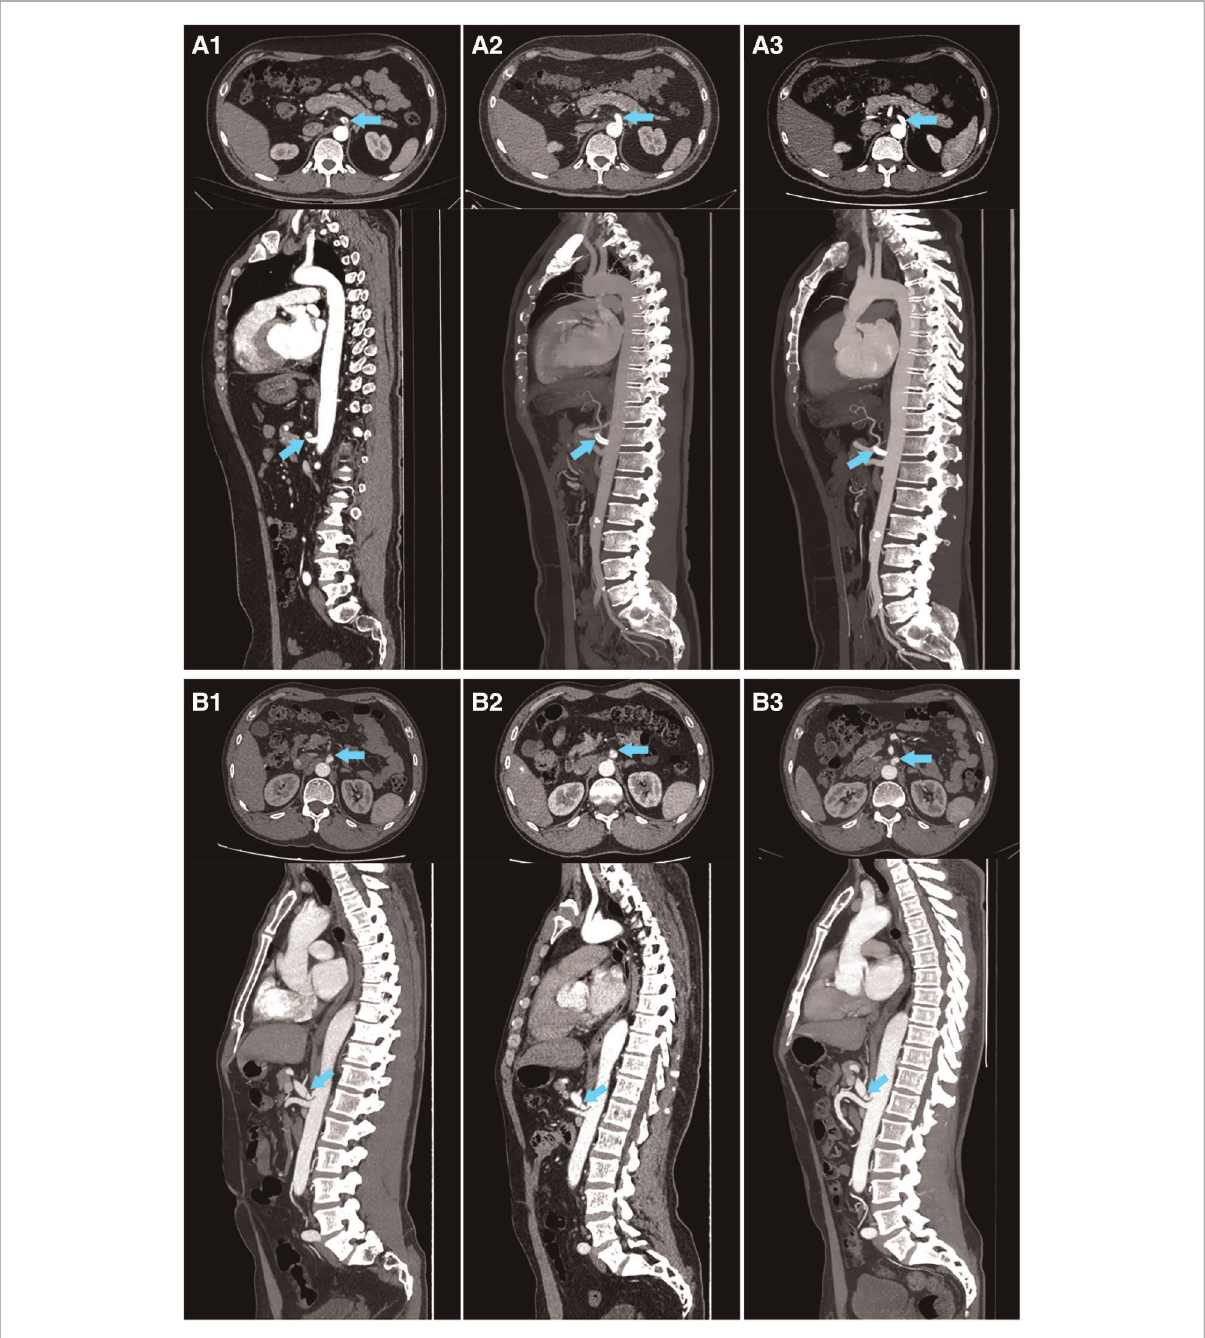
FIGURE 2 An example of a comparison of imaging follow-up for the conservative treatment and endovascular treatment groups. ( A ) A 46-year-old Male, who was diagnosed with symptomatic spontaneous isolated celiac artery dissection, underwent endovascular treatment. A1 – A3 are the imaging scans before stent implantation, one week after stent implantation, and 12 months after stent implantation, respectively, showing a complete and stable remodeling of the celiac artery within a short term. ( B ) A 59-year-old Male, who was diagnosed with symptomatic spontaneous isolated celiac artery dissection, underwent conservative treatment. B1 – B3 are the imaging scans presenting a persistent patent false lumen on admission, at follow-up of 3 months and 39 months,